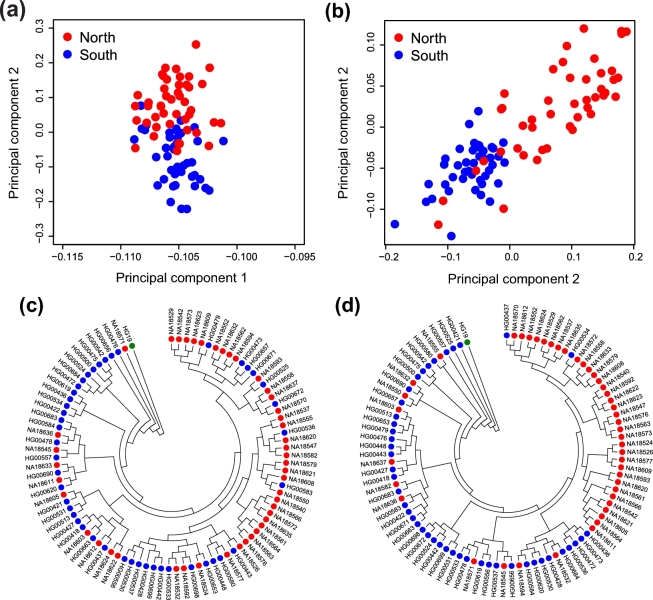
Phylogenetic analysis using RIPs and SNPs. (a) The detected RIPs were used for PCA. Each dot represents a sample from YH90 and is plotted in a scatterplot using PC1 and PC2. Red indicates samples from individuals from northern China, and blue indicates individuals from southern China. (b) The detected SNPs were used for PCA. The plot layout and legend are the same as those presented in (a). (c) Phylogenetic tree constructed using the detected RIPs. HG19 (green) is used as a control. Red indicates samples from individuals from northern China, and blue indicates samples from individuals from southern China. (d) Phylogenetic tree constructed using the detected SNPs. HG19 (green) is used as a control. Plot layout and legend are the same as that presented in (c).